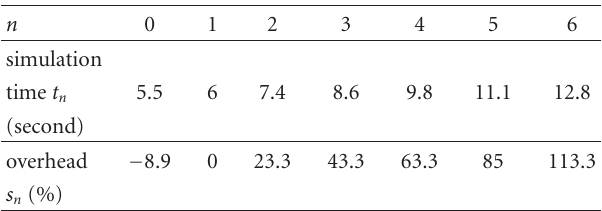
Table 2: Simulation overhead versus number of